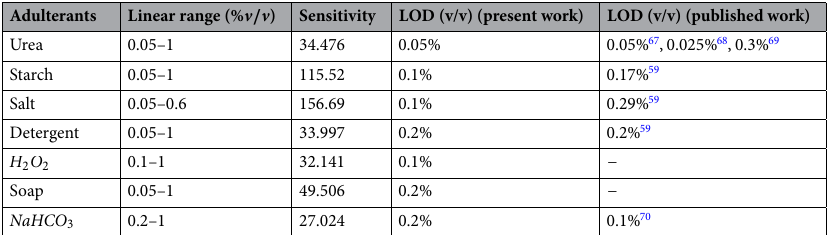
Table 1. Comparison of the limit of detection of the colorimetric technique for the adulterants in the present work and the existing different techniques.